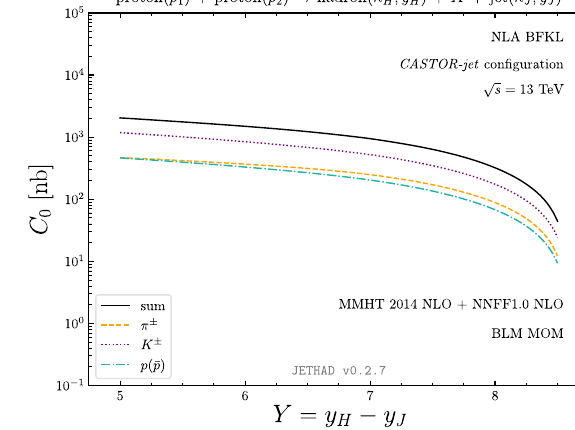
be resummed to all orders. We note that error bands in the DGLAP case are larger with respect to the resummed